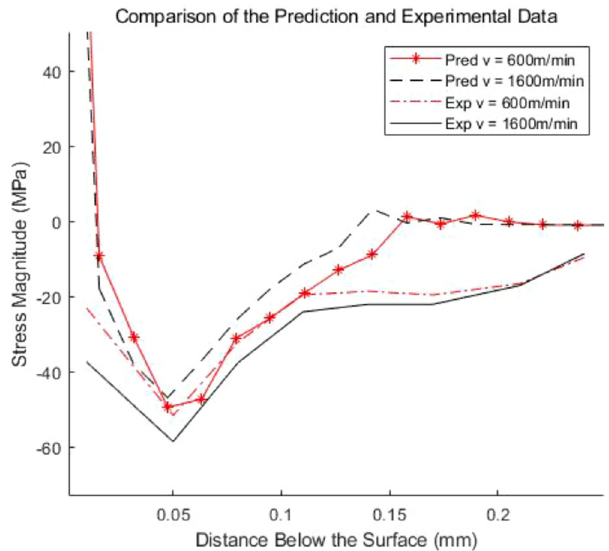
Fig. 9. Comparison of the predictive data to experimental data at f z = 0.2mm and depth of cut =0.5 mm under MQL with different cutting